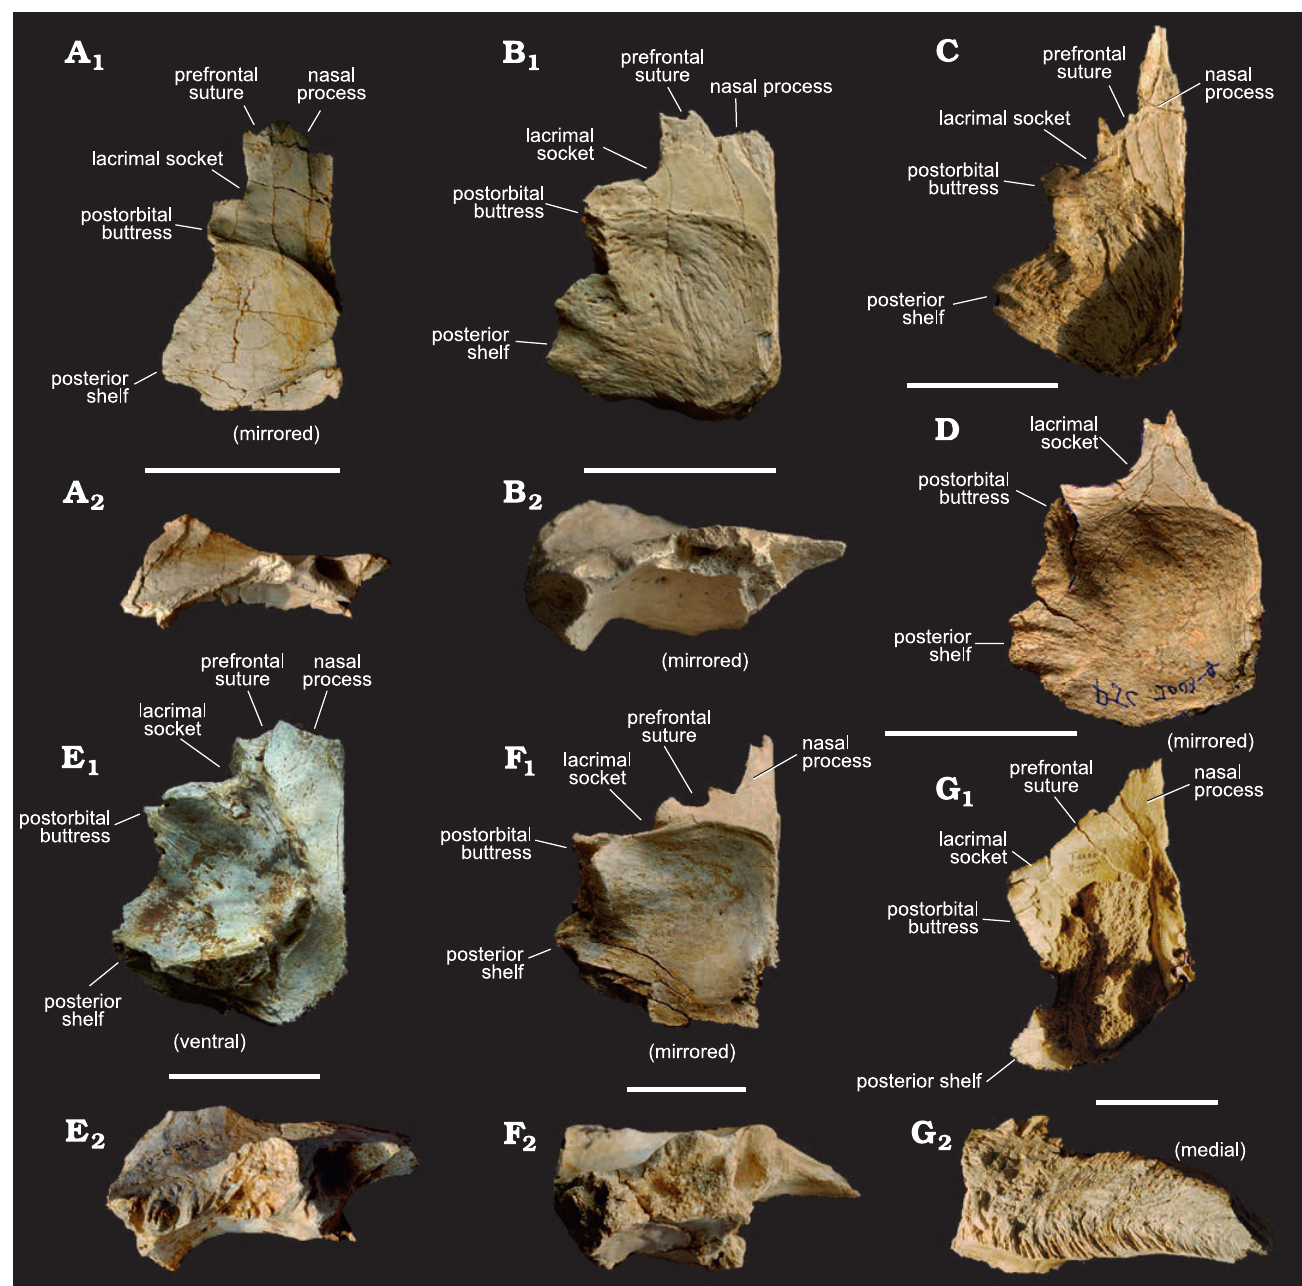
Fig. 1. Tyrannosaurid theropod Tarbosaurus bataar Maleev, 1955a from Mongolia, Nemegt Formation, Maastrichtian; frontals used to create bone silhou- ettes for superimposition. A . MPC-D 107/10, from Bugiin Tsav, in dorsal (A 1 ) and lateral (A 2 ) views. B . MPC-D 107/09, Bugiin Tsav, in dorsal (B 1 ) and lateral (B 2 ) views. C . MPC-D 107/05, Nemegt, in dorsal view. D . MPC-D 107/11, Bugiin Tsav, in dorsal view. E . MPC-D 107/13, Nemegt, in dorsal (E 1 ) and lateral (E 2 ) views. F . MPC-D 107/22, Bugiin Tsav, in dorsal (F 1 ) and lateral (F 2 ) views. G . MPC-D 107/06, Bugiin Tsav, in dorsal (G 1 ) and medial (G 2 ) views. The arrangement is from smallest to largest. Scale bars 50 (7) length of the dorsotemporal fossa between the middle rior point of the posterior part of the suture; (11) dorsoven- of the dorsotemporal ridge and the frontoparietal suture; tral depth of the anterior part of the postorbital suture; (12) (8) length of the brain between most anterior point of the dorsoventral depth of the posterior part of the postorbital olfactory bulb fossa and the most posterior point of the suture (Fig. 2). Note that the postorbital suture of the frontal cerebral fossa; (9) depth of the frontal at the region that is has two distinct regions, which is why two measurements immediately anterior to the most anterior point of the sag- (Fig. 2: 11, 12) were taken. The anterior part of the postor- ittal crest; (10) length of the postorbital suture between the bital suture is usually taller, narrower, and oriented more most anterior point of the anterior part and the most poste- laterally than the posterior part of the postorbital suture.